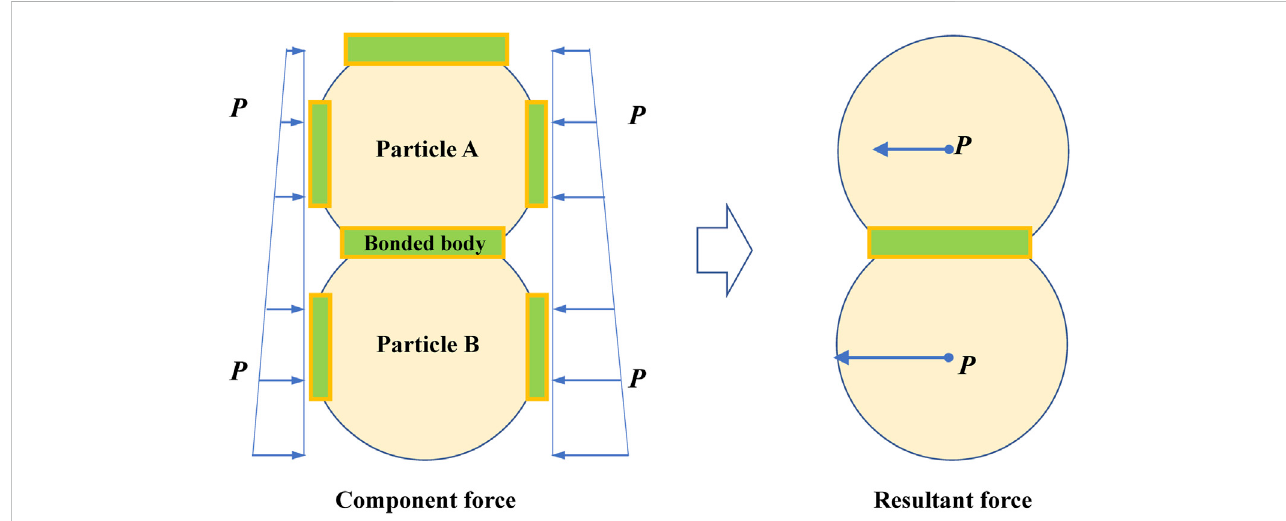
FIGURE 6 Schematic diagram of pore water pressure distribution and resultant force when x -direction shear failure is